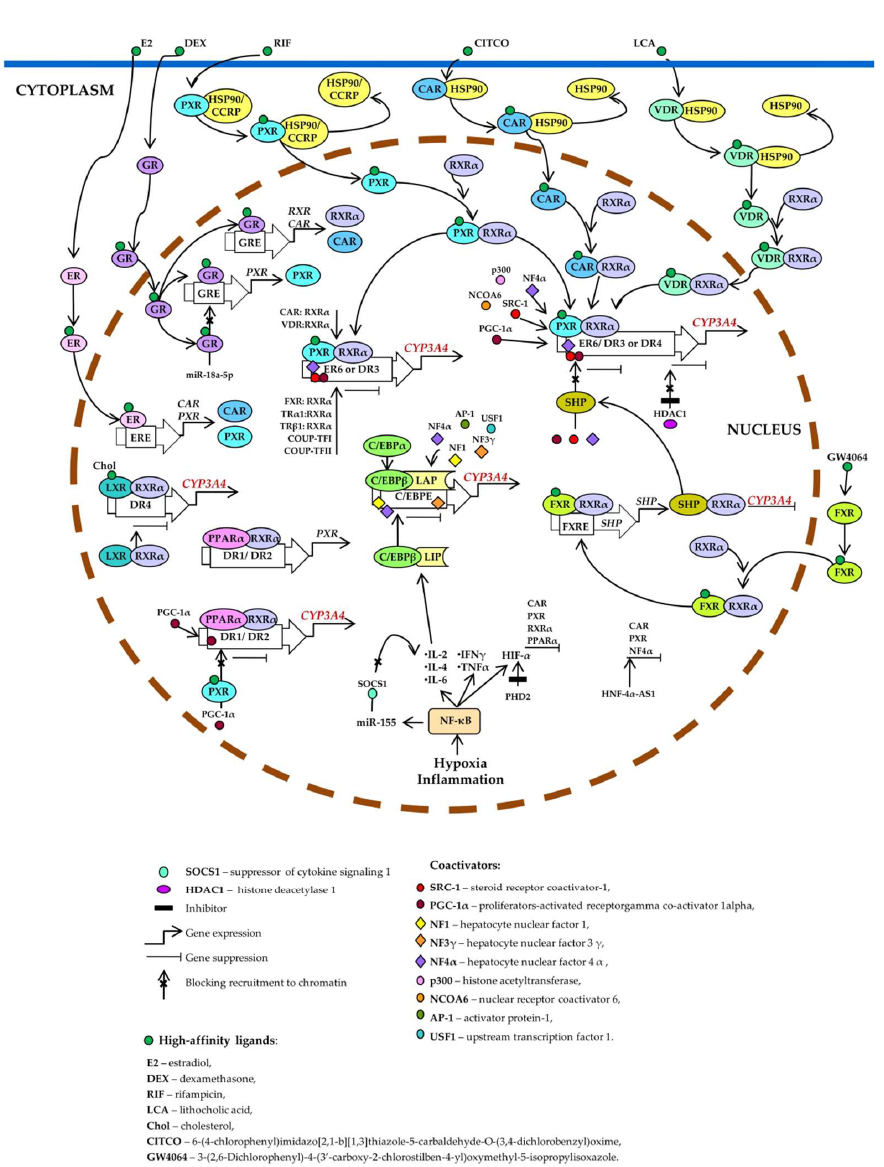
Figure 3. Transcriptional regulation of CYP3A4. Pregnane X receptor (PXR), constitutive androstane receptor (CAR), and vitamin D receptor (VDR) control basal and inducible expression of CYP3A4 through competitive binding to the same set of response elements (everted repeats 6, ER6; direct repeats DR3, and DR4). PXR, CAR, or VDR unbound by a ligand is located in the cytoplasm as a complex with heat shock protein 90 (HSP90) or cytoplasmic constitutive active/androstane receptor retention protein (CCRP). When activated by a ligand, each of them forms a heterodimer with retinoid X receptor α (RXR α ), relocates to the nucleus, binds to a response element, recruits coactivators, and activates CYP3A4 transcription. Estrogen receptor (ER) and glucocorticoid receptor (GR) raise CYP3A4 expression by enhancing the expression of CAR, RXR α , and PXR. Ligand-activated farnesoid X receptor (FXR) upregulates small heterodimer partner (SHP), which prevents the recruitment of coactivators to chromatin and/or forms heterodimers with RXR α , thereby inhibiting CYP3A4 expression. Histone deacetylase 1 (HDAC1) inhibition by carbamazepine downregulates CYP3A4. Liver X receptor (LXR) forms a heterodimer with RXR α that then binds to DR4 in the target gene, thus repressing its expression. After the binding of a ligand to LXR or RXR, the heterodimer changes its conformation, which leads to a release of corepressors and the recruitment of coactivators. This event causes transcription of a target gene (peroxisome proliferator-activated receptor alpha; PPAR α